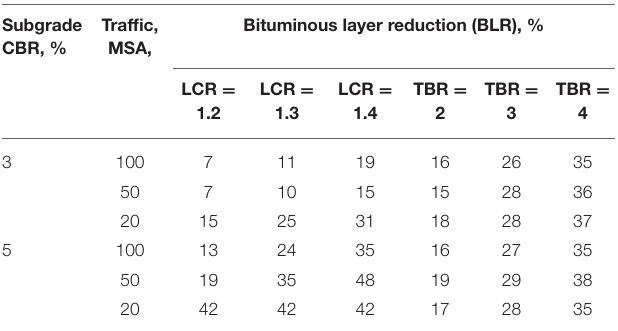
TABLE 4 | Unit EC values for selected materials from the literature.